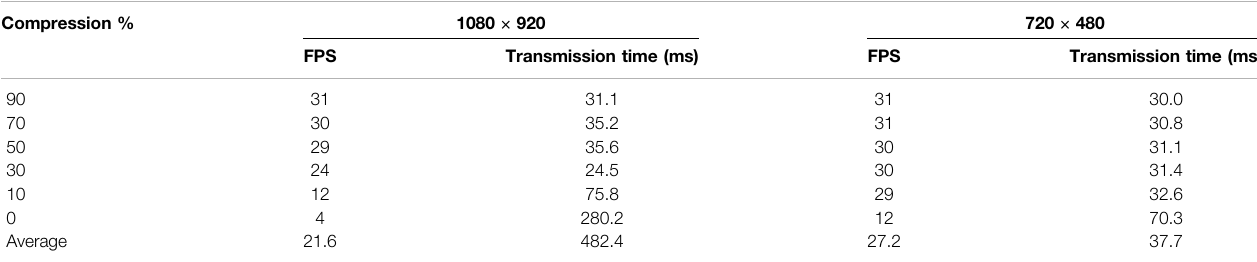
TABLE 2 | Effect of JPEG compression on latency and